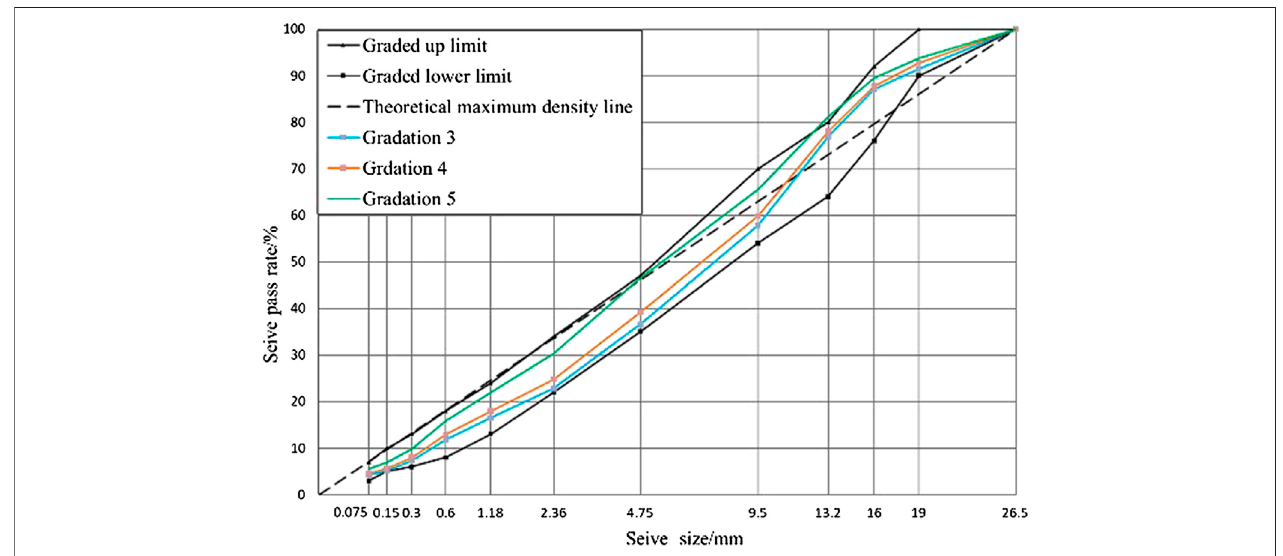
FIGURE 2 | Possible actual curves of dense skeleton gradation.